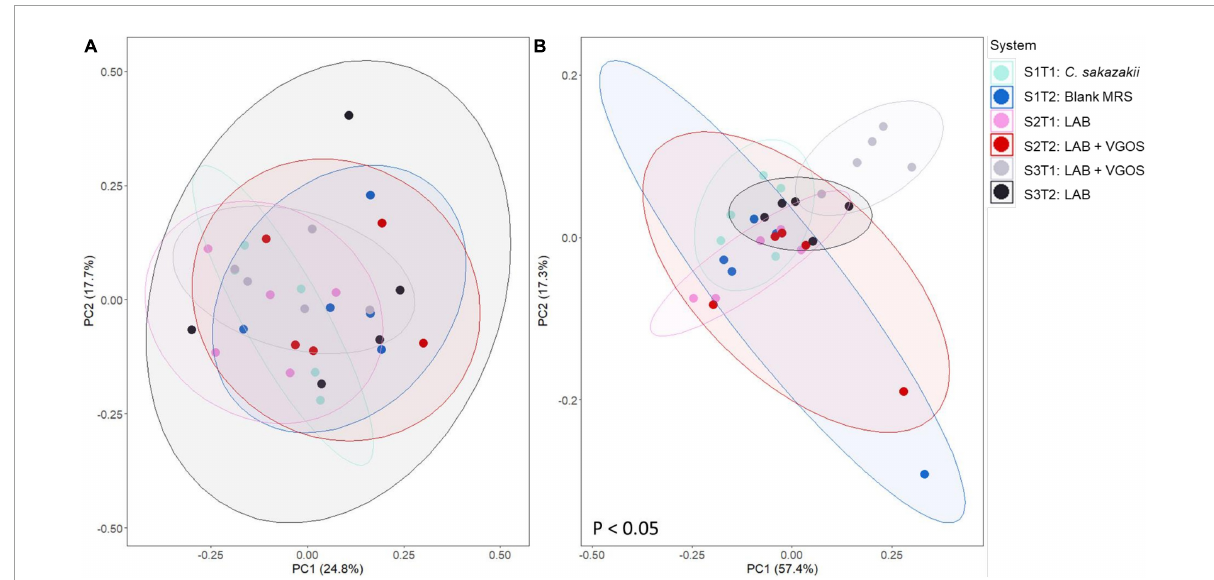
FIGURE8 Principal coordinate analyses (PCoA) plots of unweighted UniFrac (A) and Bray-Curtis dissimilarity (B) based on operational taxonomical units from SHIME samples as visualized by treatment periods and SHIME, with ellipses indicating 80% confidence interval. The labels indicate the SHIME and treatment period. For example, S1T1 indicates that the light blue samples are for the first treatment period of SHIME 1. Each SHIME is represented by a different color and treatment periods are differentiated by the shade of the color, i.e., light or dark shade. Significant differences in groups were calculated based on PERMANOVA and adjusted using the Benjamini-Hochberg false discovery rate ( p < 0.05).